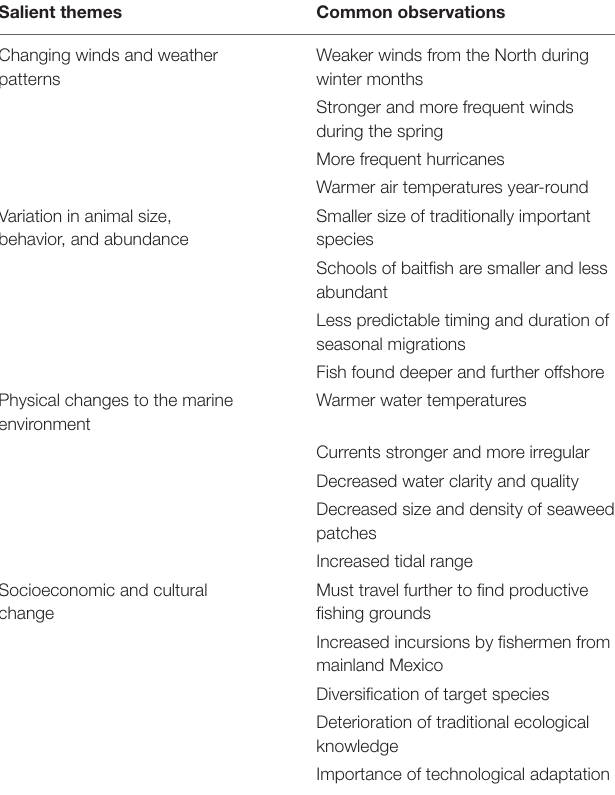
TABLE 1 | Common observations of social-ecological change over the past decade as described by small-scale fisher informants ( n = 35) of Santa Rosalía (Central Gulf of California) during the summer of 2015.